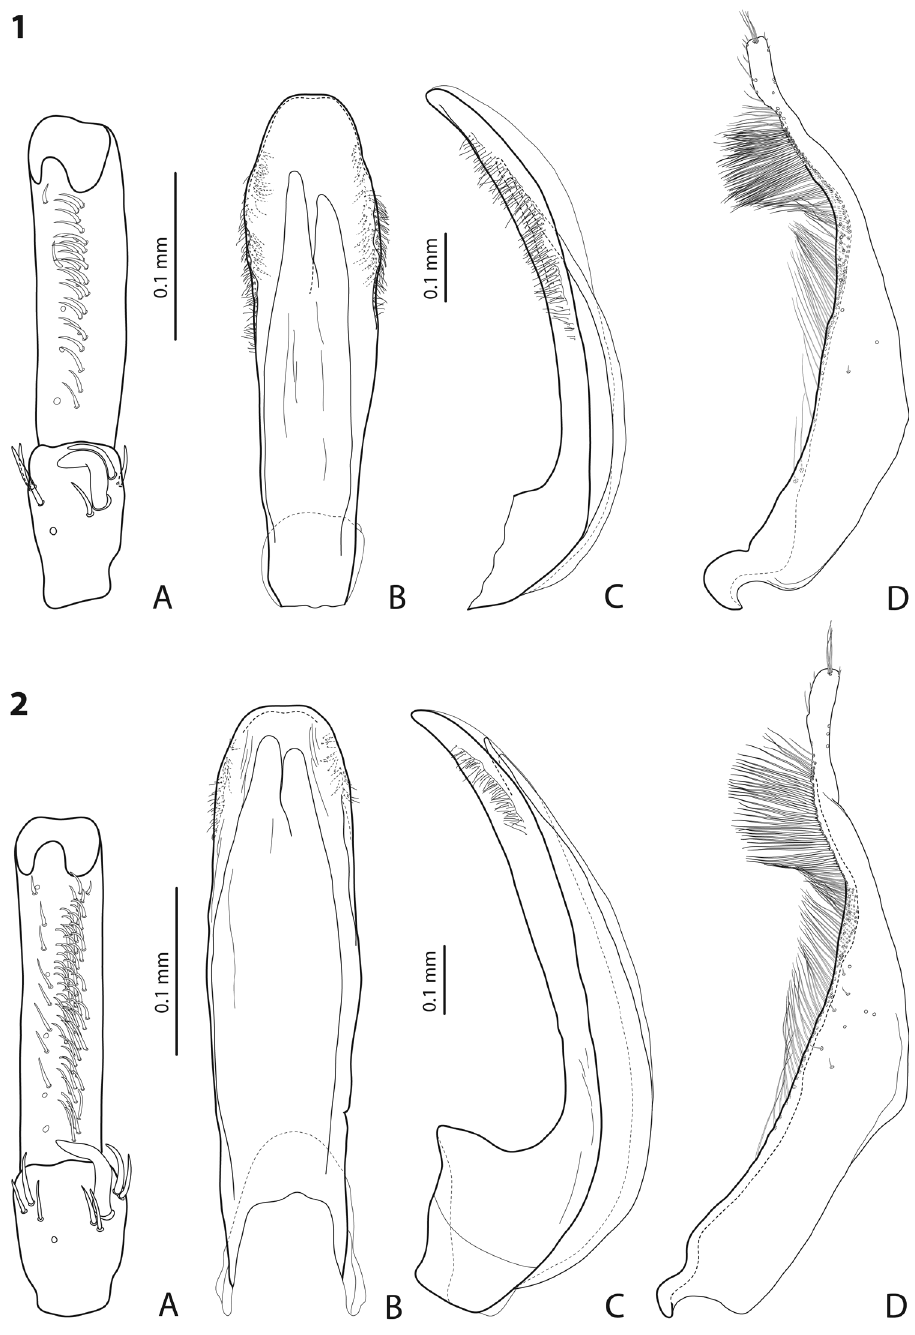
mere in external